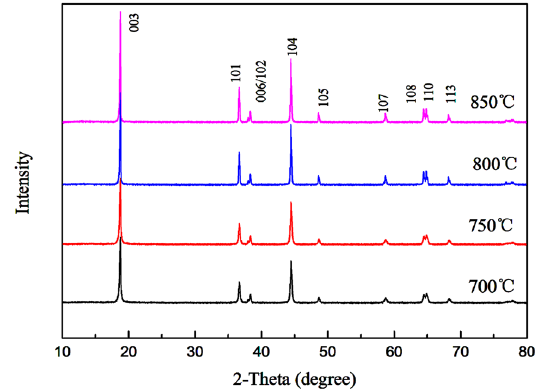
Figure 3: XRD pattern of LiNi 0.8 Co 0.15 Al 0.05 O 2 prepared at di ff erent calcination temperatures.